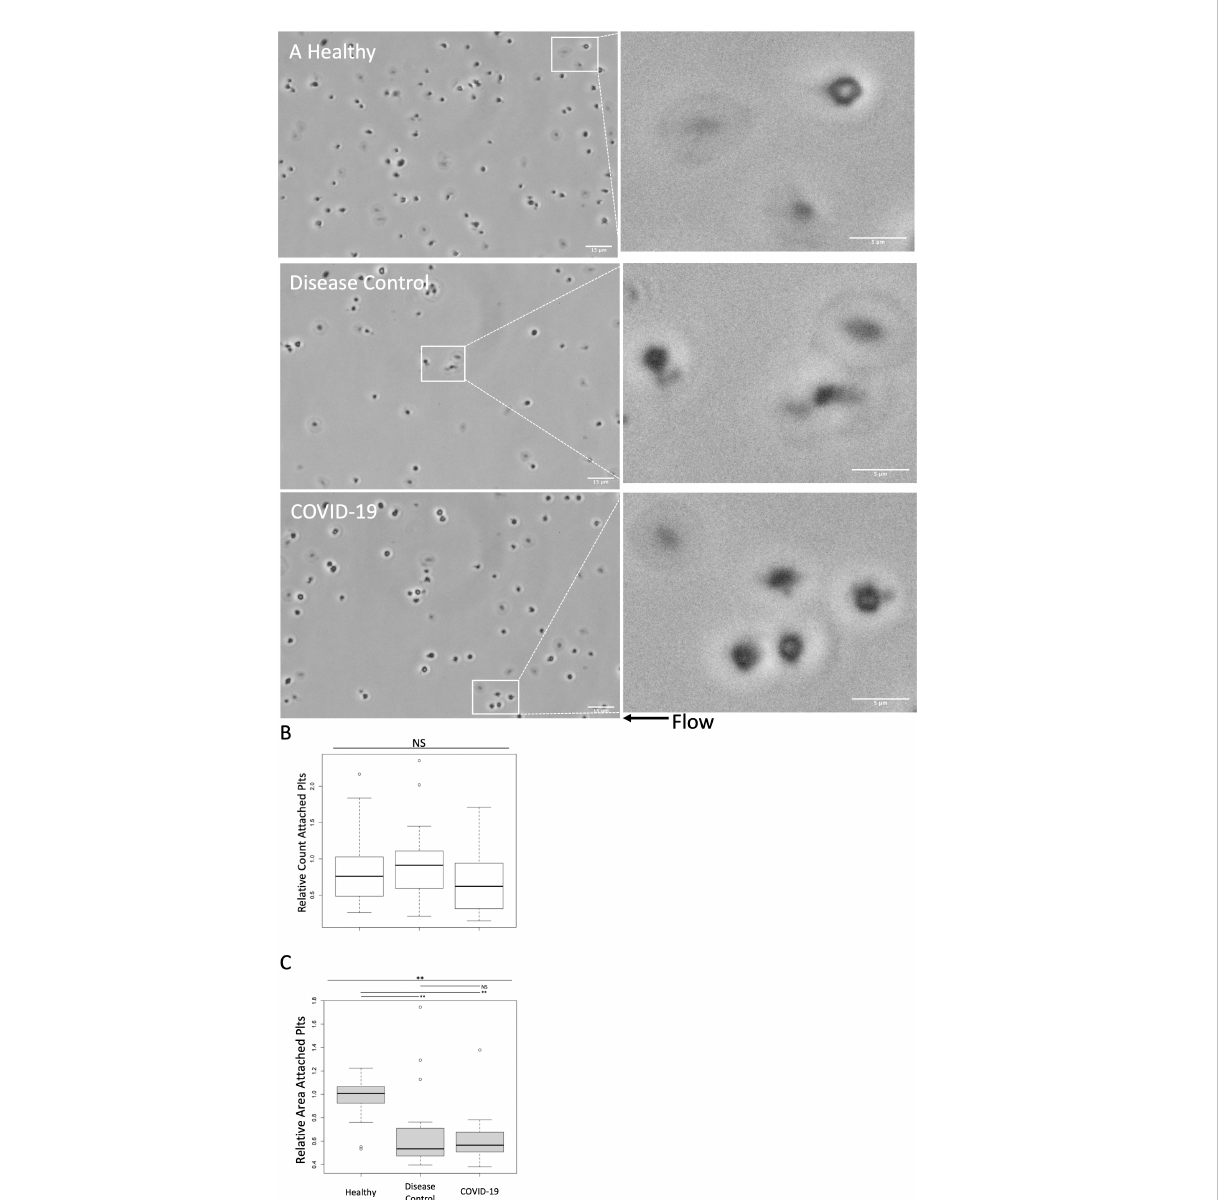
FIGURE 3 Adhesion and morphologic effects of healthy platelets treated with plasma from COVID-19 patients and disease controls was measured in a micro fl uidic adhesion assay. Healthy donor platelets were treated with plasma from COVID-19 patients, and healthy and disease controls, and then were passed through a collagen and thromboplastin coated chamber at 100s -1 (approximately venous shear). Unattached platelets were washed out at 1000s -1 (approximately arterial shear). Attached platelets were examined by phase contrast microscopy at 60X. (A) Representative images. In general, compared to healthy plasma treated platelets, treatment with plasma from both COVID-19 patients and disease controls induced platelets to adopt small and rounded phenotypes. Scale Bars are 15 m m and 5 m m for zoomed out and zoomed in panels, respectively (B) Attached platelets in fi ve 60X fi elds were counted and counts were normalized to an autologous plasma treated group performed in tandem. The number of adhered platelets did not differ signi fi cantly between groups (C) Area of attached platelets was quanti fi ed to further examine morphological changes. Adhered platelets were signi fi cantly smaller following treatment with plasma from both COVID-19 patients and disease controls compared to healthy. There was not, however, a signi fi cant quantitative difference between treatment with plasma from COVID-19 patients compared to disease controls. Overall, the morphologic changes suggest that the circulating milieu in both COVID-19 patients and disease controls induced similar adhesive effects on healthy platelets. Treatment with plasma from COVID-19 patients did induce a qualitative increase in morphologic process development. Platelets from one of two male or two female healthy donors were treated with plasma from seven healthy donors, 12 disease control, and 14 COVID-19 patients. All plasma treatments were normalized to autologous healthy donor plasma treatment collected in tandem. Statistical signi fi cance was assessed using the Kruskal-Wallis test followed by pairwise Wilcoxon Signed-Rank tests. NS, not statistically signi fi cant; *, p ≤ 0.05; **, p ≤